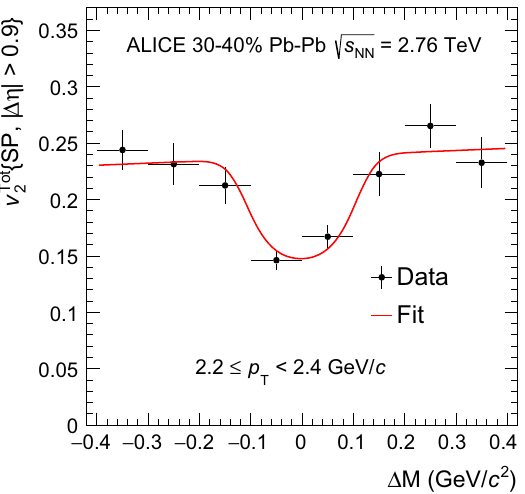
background. Right: The v 2Tot vs (cid:14) M for d+d for 2.2 ≤ p T < 2.4 GeV / c in events with 30–40% centrality. Points represent the measured v Tot while the curve is the fit performed using Eq.